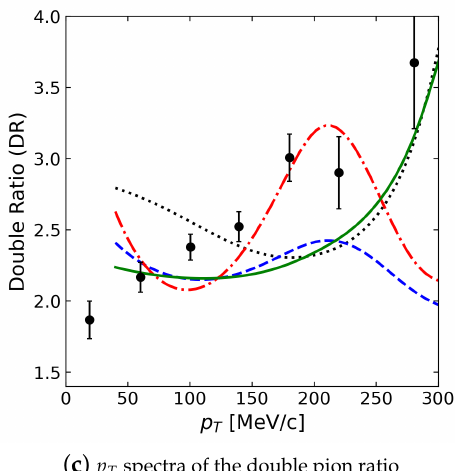
Figure 4. ( a ) Single-pion ratio as a function of transverse momentum for neutron-rich system with N / Z = 1.56 ( 132 Sn+ 124 Sn). ( b ) The same for a neutron-deficient system with N / Z = 1.2 ( 108 Sn+ 112 Sn). ( c ) Transverse momentum spectra of the double ratio of two Sn collision systems, Equation (22). Circle markers with uncertainties are experiment data taken from Ref. [40] and the curves are the ratios corresponding to four different parameter